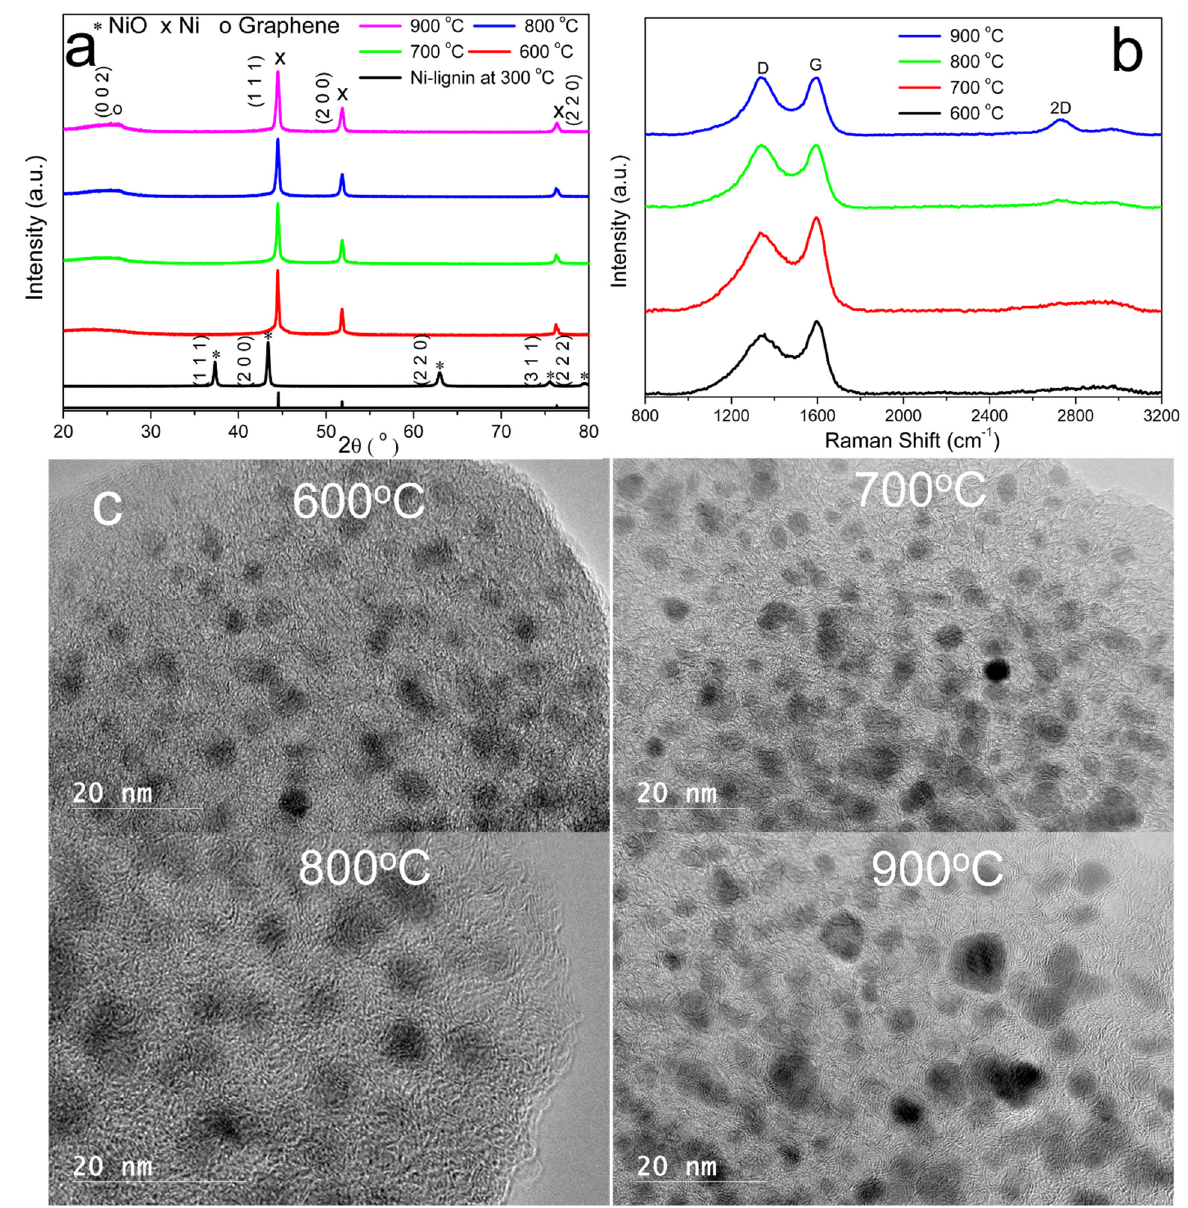
Figure 2. X-ray diffraction (XRD) patterns ( a ), Raman spectra ( b ), and HRTEM images ( c ) of 10% Ni- lignin composite catalytically graphitized under argon atmosphere at different temperatures.